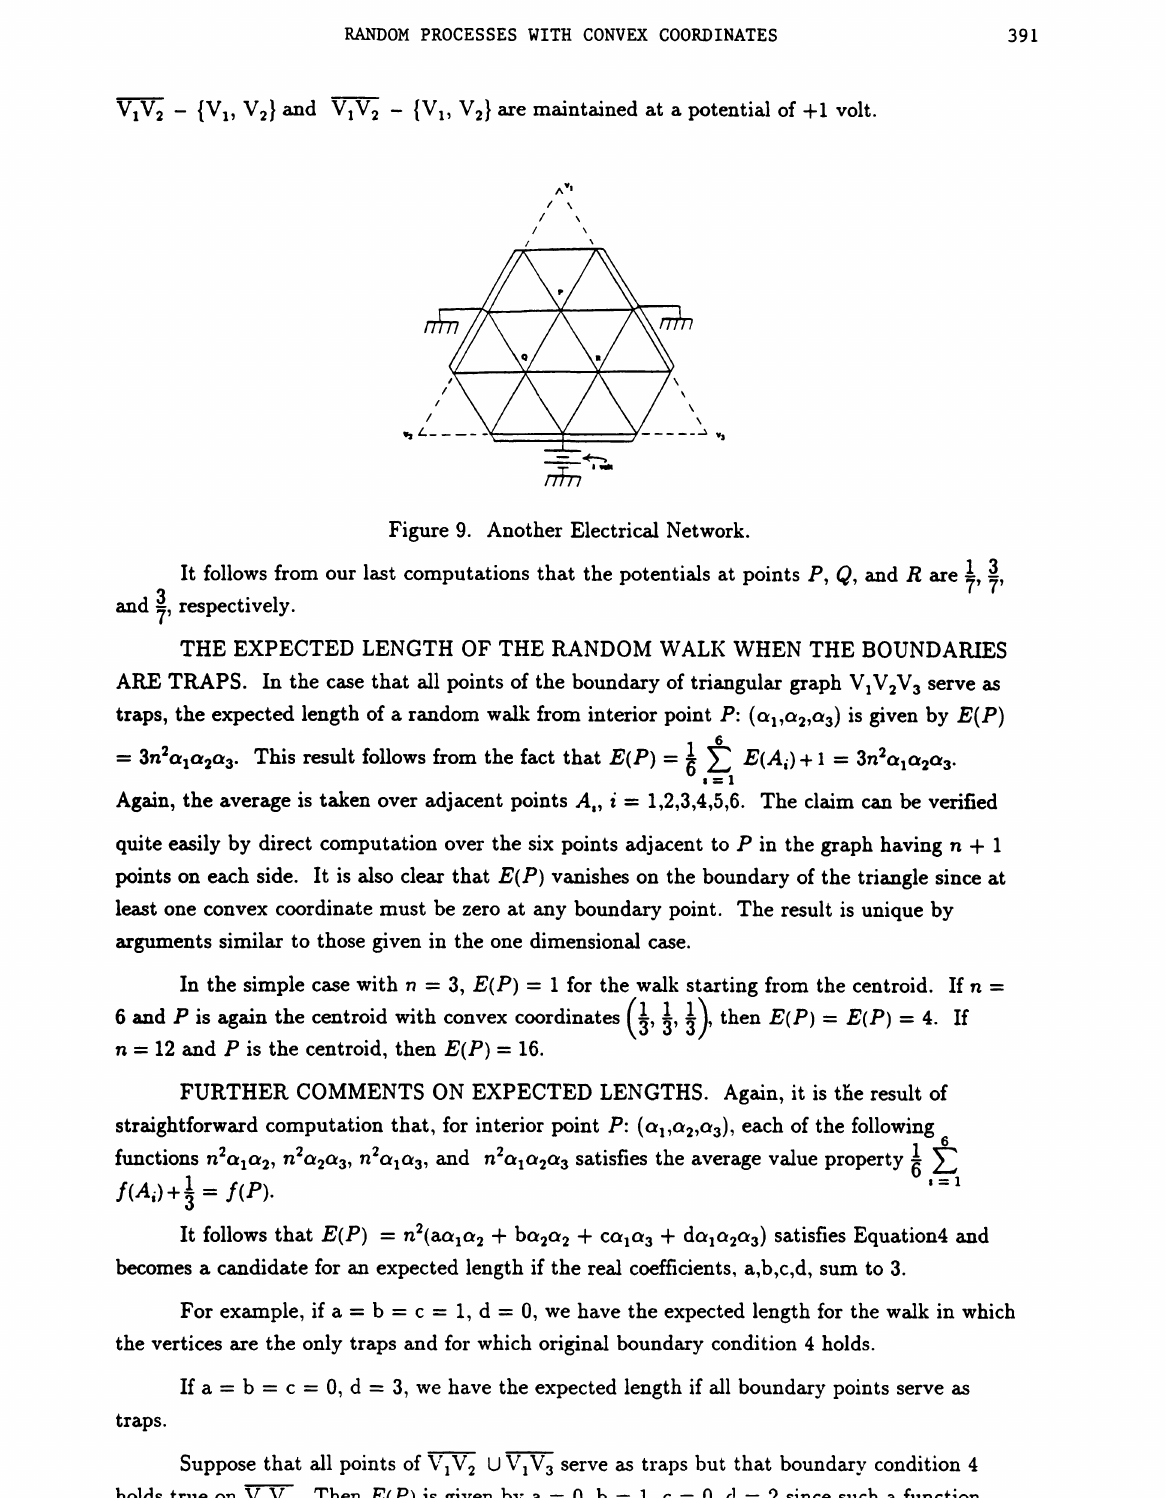
Figure 9. Another Electrical